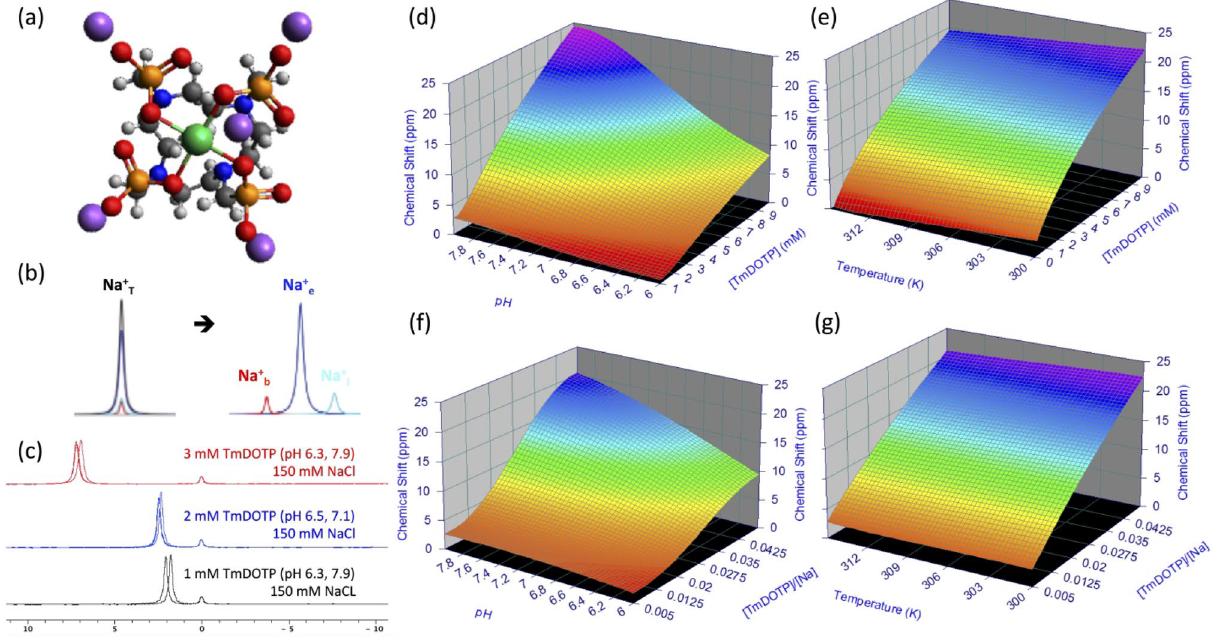
Figure 1. Shifting mechanism of the 23 Na resonance in vitro. ( a ) Chemical structure of sodium thulium(III) 1,4,7,10-tetraazacyclododecane-1,4,7,10-tetrakis(methylenephosphonate) (Na 5 TmDOTP). The TmDOTP 5− complex consists of the Tm 3+ ion chelated with DOTP 8− . Each phosphonate-containing pendant arm on TmDOTP 5- has electron-donating groups on the oxygen atoms (red) to stabilize the Tm 3+ conjugation with DOTP 8− . The -5 charge simultaneously attracts five Na + ions (purple), which experience a shift in the observed 23 Na resonance that is dependent on [TmDOTP 5− ]. ( b ) In vivo, prior to TmDOTP 5− administration (left), the 23 Na spectrum yields only a single peak representing the total sodium (Na + T ) comprising blood (Na + b ), extracellular (Na + e ), and intracellular (Na + i ) compartments. Following TmDOTP 5− administration (right), the peaks become spectroscopically separable based on [TmDOTP 5− ] in each compartment. Integrals of these peaks will be representative of aqueous [Na + ] in each compartment. ( c ) A two-compartment coaxial cylinder tube setup was employed for in vitro observation of the chemical shift separation scheme (Figure S1). The inner tube (smaller volume) was filled with 150 mM NaCl, while the outer tube (larger volume) was filled with the same solution in addition to various amounts of TmDOTP 5− , each subject to different pH conditions. Thus, all 23 Na spectra from this phantom setup displayed a small unshifted peak from the inner compartment and a larger shifted peak. The outer-to-inner volume ratio was 8.6, explaining the difference in sizes of the peaks. Exemplary traces of 23 Na spectra show that the shift is much more sensitive to [TmDOTP 5− ] (2.77 ppm/mM) than to variations in pH (0.25 ppm/pH unit) or temperature (0.03 ppm/°C). The downfield peaks in the red, blue, and/ or black spectra are shifted differently due to varying TmDOTP 5− concentrations, and these shifts exceed those caused by pH, but all of these shifts are detectable independent of broadening caused by TmDOTP 5− (see also Figure S1). Plots ( d , e ) show that temperature, pH, and [TmDOTP 5− ] all contribute to variations of the 23 Na chemical shift. However, these plots depict ranges of pH and temperature that are unlikely for in vivo settings (i.e., changes over 2 full pH units and temperature changes over 15 °C). Moreover, [Na + ] in vivo (~ 150 mM in blood and extracellular space) is extremely high compared to [TmDOTP 5− ]. Therefore, variations in 23 Na chemical shift are primarily dependent on [TmDOTP 5− ]/[Na + ] thereby rendering ( f ) pH and ( g ) temperature dependencies negligible. Data points were fit to Chebyshev rational polynomials using TableCurve 3D v4.0.05 (Systat Software, San Jose, CA, USA; https:// systa tsoft ware. com/ produ cts/ table curve- shown for pH (2 full pH units) and temperature (15 °C interval) are overestimated, and where [Na + ] far exceeds [TmDOTP 5- ] based on prior experiments 37 . In blood and extracellular spaces, [Na + ] is ~ 30–100 × greater than [TmDOTP 5- ] 36 . This suggests that the relative amount of TmDOTP 5- (Fig. 1f,g) is the primary factor affecting 23 Na chemical shift (Eq. (4) in Supplementary: Theory).